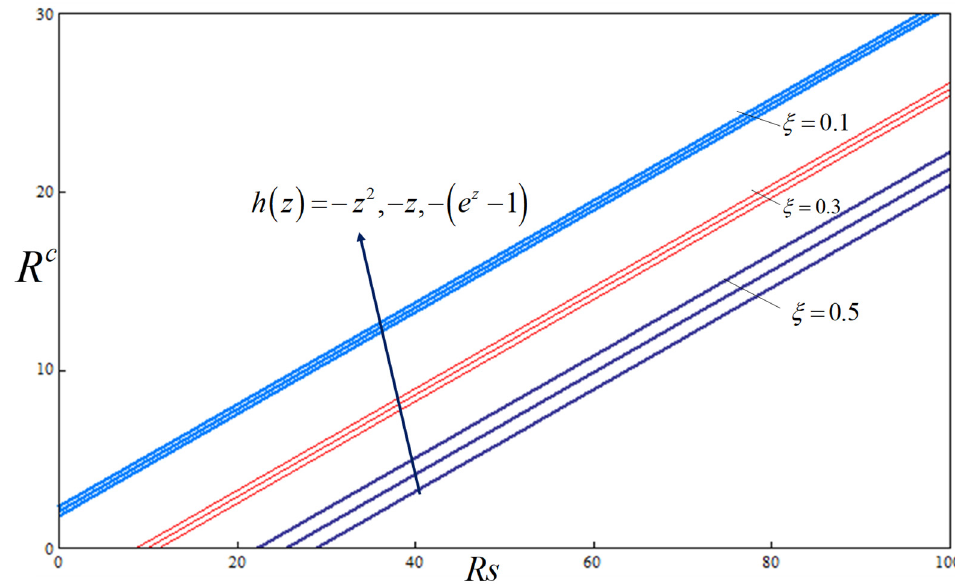
Figure 13. Plot of R c versus Rs for three cases of negative gravity fluctuation for various values of ξ with Le = 0.5, Rs = 10, Da = 0.1, η = 0.5 and δ = 0.5.